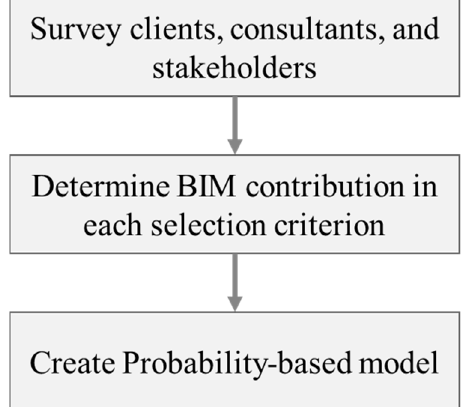
Figure 5. Methodology of probability-based model generation.